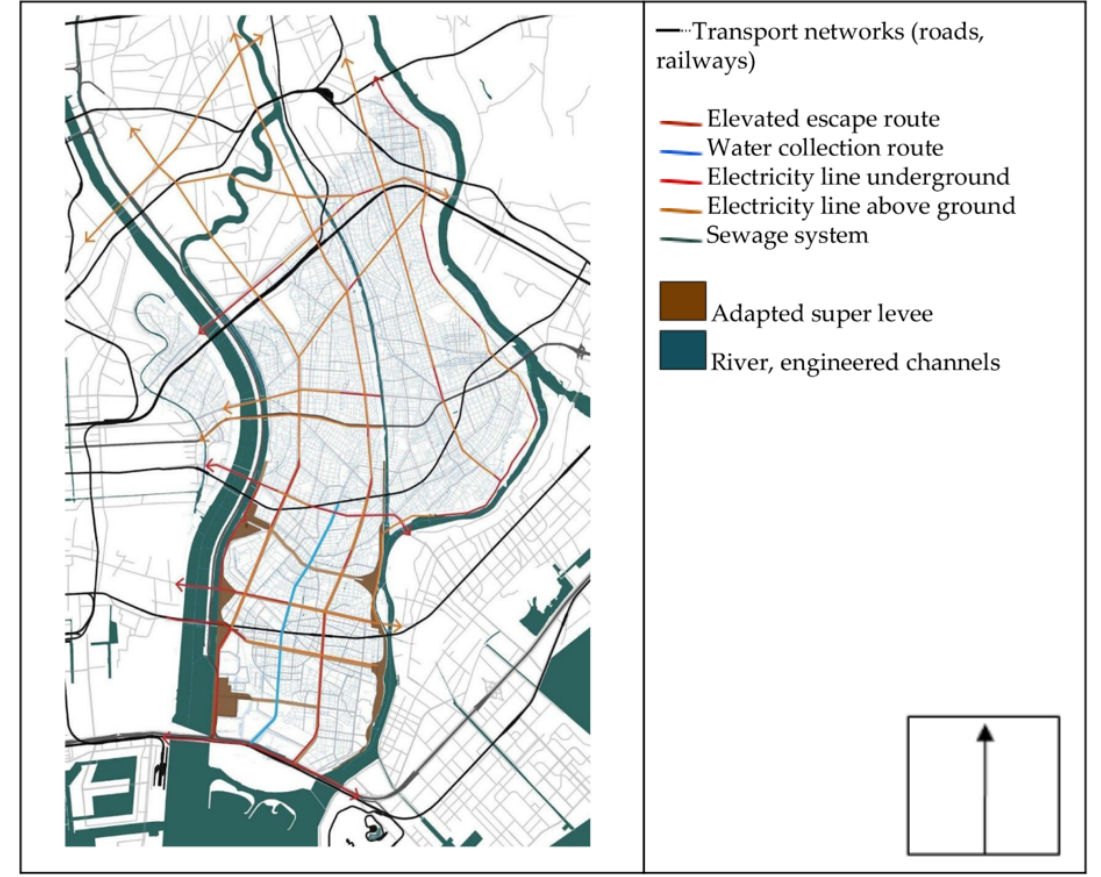
Figure 16. Strategy B—pro/integrated super levee overlaid with vital infrastructure (electricity, transport, sewage) (Source: Drawn using data from MLIT Japan and Edogawa Ward data, 2016)